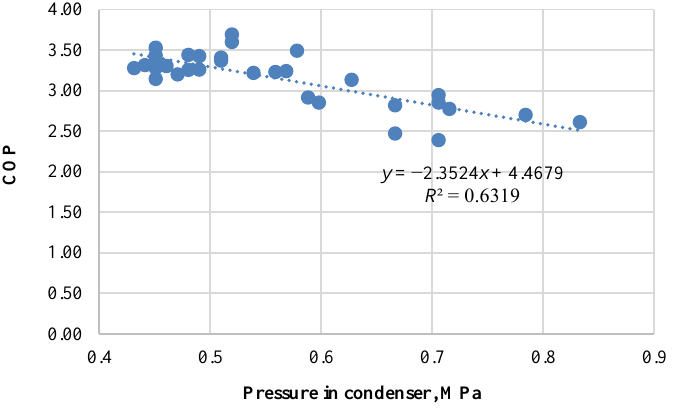
Fig. 6. Two-stage compressor COP depending on condenser pressure.